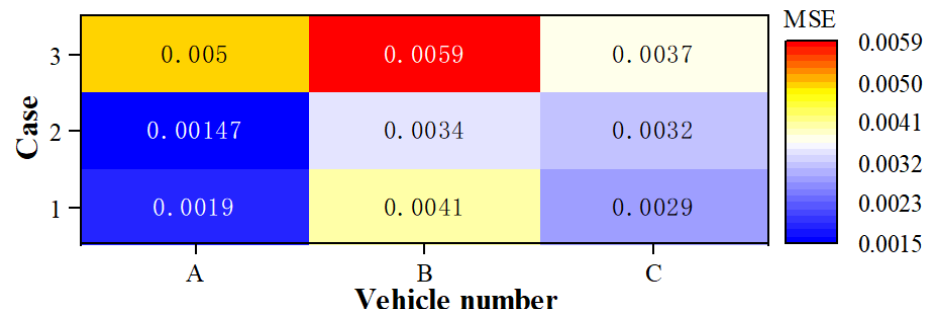
Figure 10. MSEs of SOC estimation results under different validation cases.